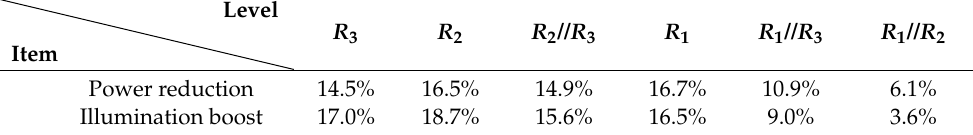
Figure 13. A conceptual diagram of the estimation method for the improvement effect. Table 2. Quantified improvement effect of each dimming level obtained by the VCSR Method.